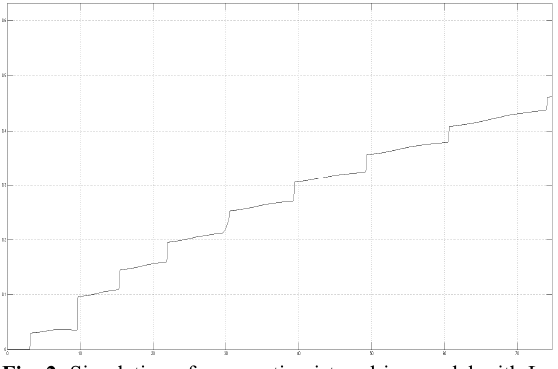
Fig. 2. Simulation of pneumatic piston drive model with Lund – Grenoble friction model (stick-slip effect) .